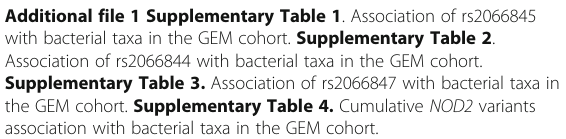
Additional file 1 Supplementary Table 1 . Association of rs2066845 with bacterial taxa in the GEM cohort. Supplementary Table 2 . Association of rs2066844 with bacterial taxa in the GEM cohort. Supplementary Table 3. Association of rs2066847 with bacterial taxa in the GEM cohort. Supplementary Table 4. Cumulative NOD2 variants association with bacterial taxa in the GEM cohort. Abbreviations CD: Crohn ’ s disease; IBD: Inflammatory bowel disease; FDR: Healthy first degree relative; GWAs: Genome-wide association studies; CCC-GEM: Crohn ’